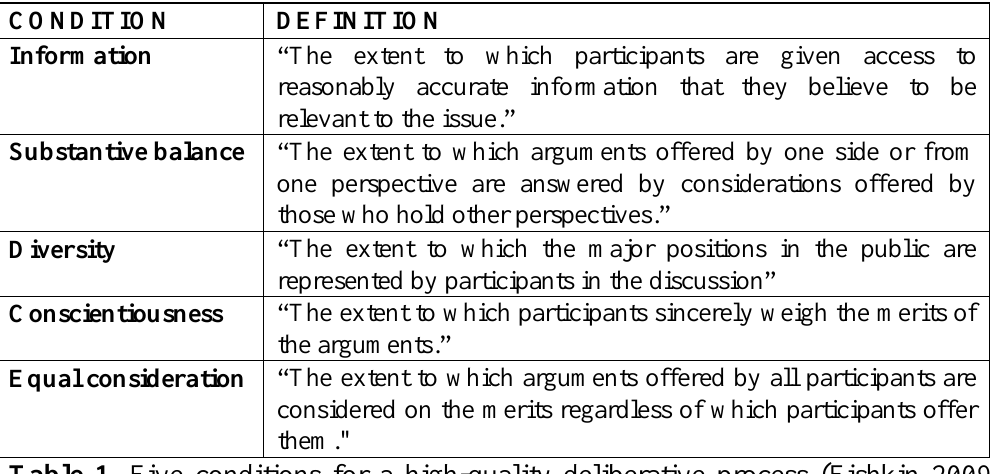
Table 1. Five conditions for a high-quality deliberative process (Fishkin 2009: